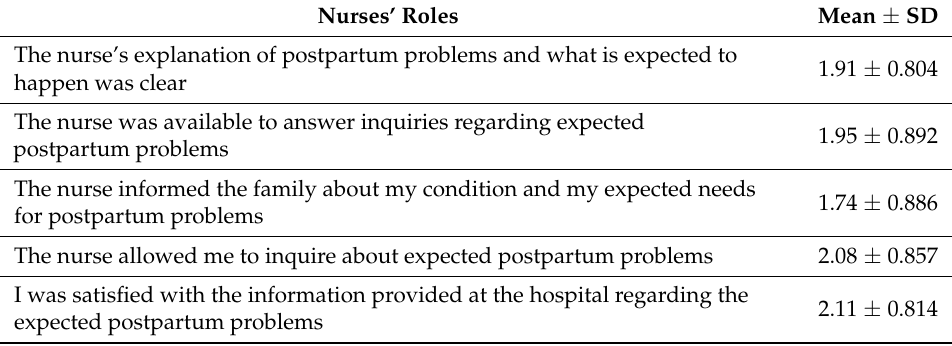
Table 6. Nurses’ roles during the postpartum period as mentioned by the study participants.